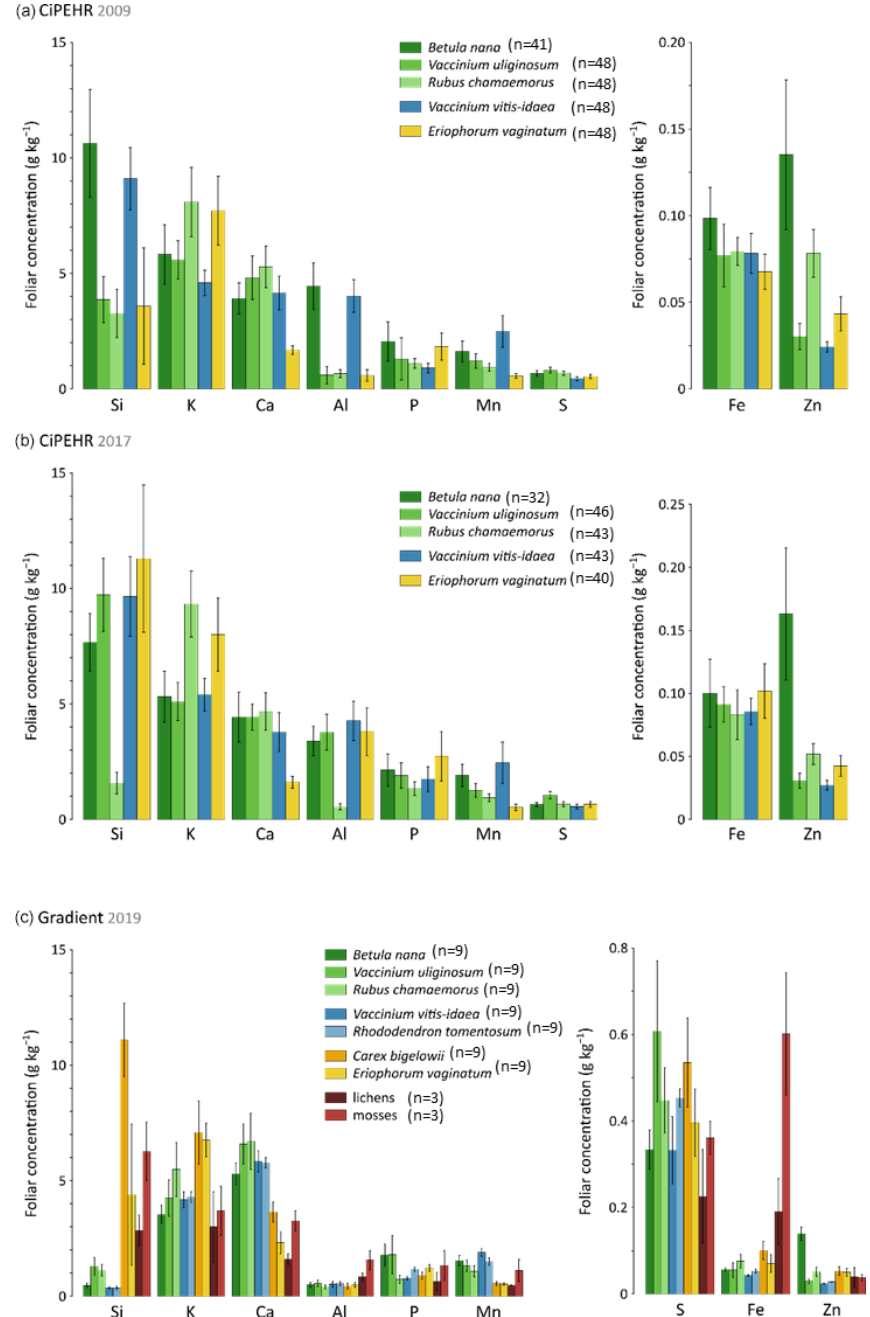
Figure 2. Mineral element concentrations (Si, K, Ca, Al, P, Mn, S, Fe, and Zn) in foliage at (a) the experimental warming site (CiPEHR; average over all warming treatments) in 2009 and (b) 2017, as well as (c) the thermokarst gradient site (Gradient; average over all degradation stages) in 2019. Vegetation is sorted by plant functional types: deciduous shrubs and forbs (green), evergreen shrubs (blue), sedges (yellow), and lichens and mosses (red). Error bars represent standard